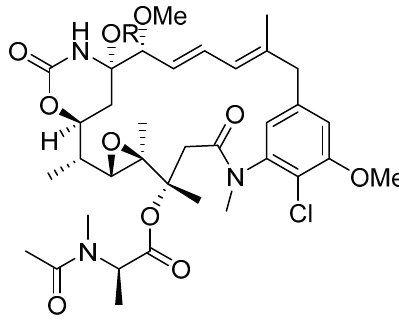
Figure 2. The structural formula of calicheamicins. Adapted from Reference [55].